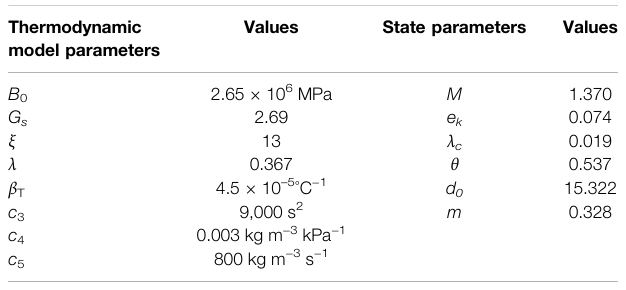
TABLE 2 | Thermodynamic parameters and state parameters in the model.